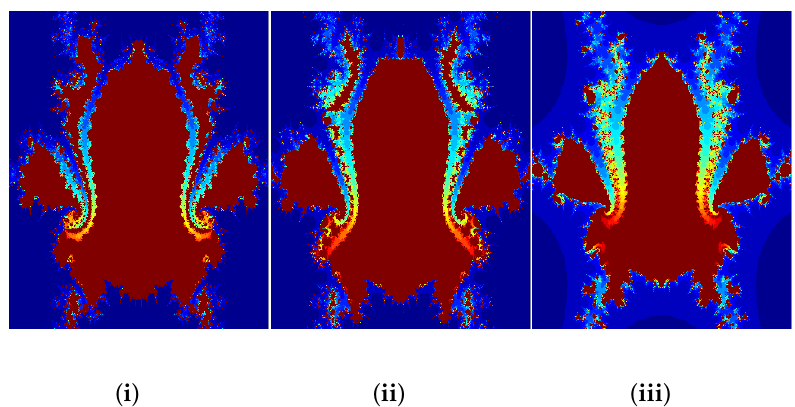
Figure 5. Cubic Julia sets in ( i ) Noor-orbit; ( ii ) Ishikawa-orbit; ( iii ) Mann-orbit.